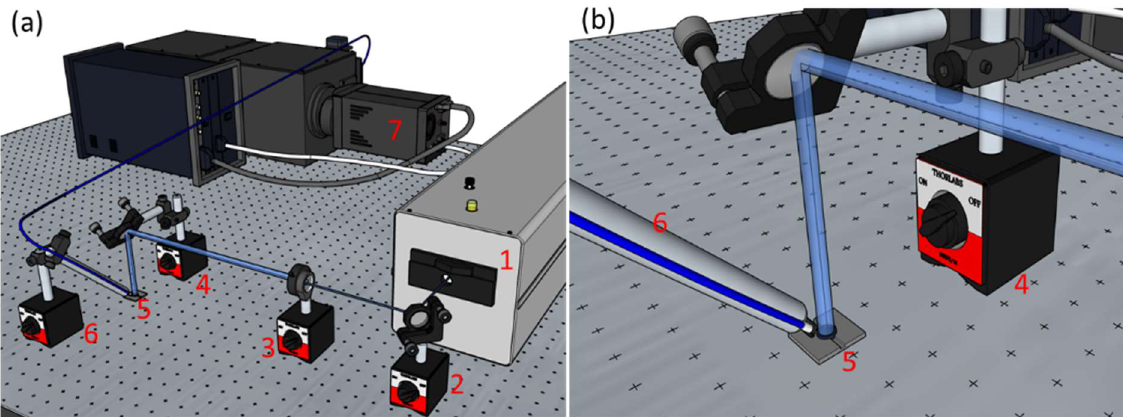
Figure 1. ( a ) The irradiation setup used to photo-crosslink hydrogels with 266 nm laser beams and the LIF signal collection of the fluorescence emission of the initiator. ( b ) closeup of the LIF signal collection. Legend: ( 1 ) Nd:YAG laser, ( 2 ) dielectric mirror, ( 3 ) lens and diaphragm, ( 4 ) dielectric mirror, ( 5 ) mold, ( 6 ) optical fiber, ( 7 ) spectrograph.